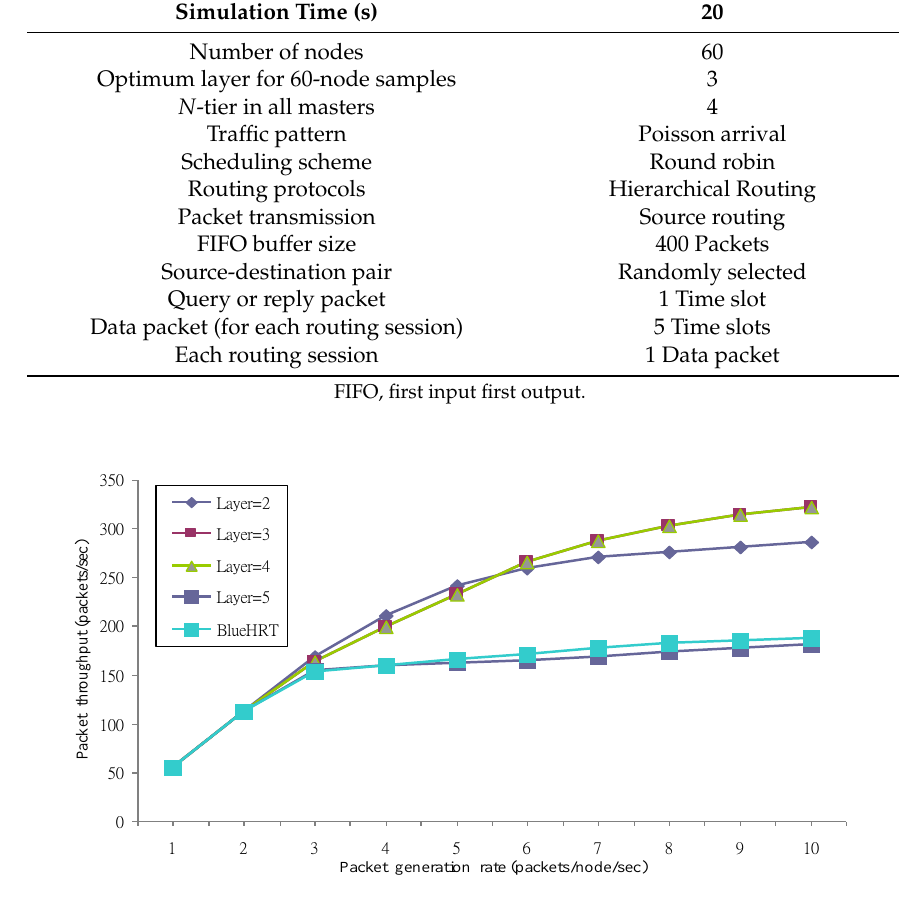
Figure 11. Average packet throughput of mesh-tree and BlueHRT.